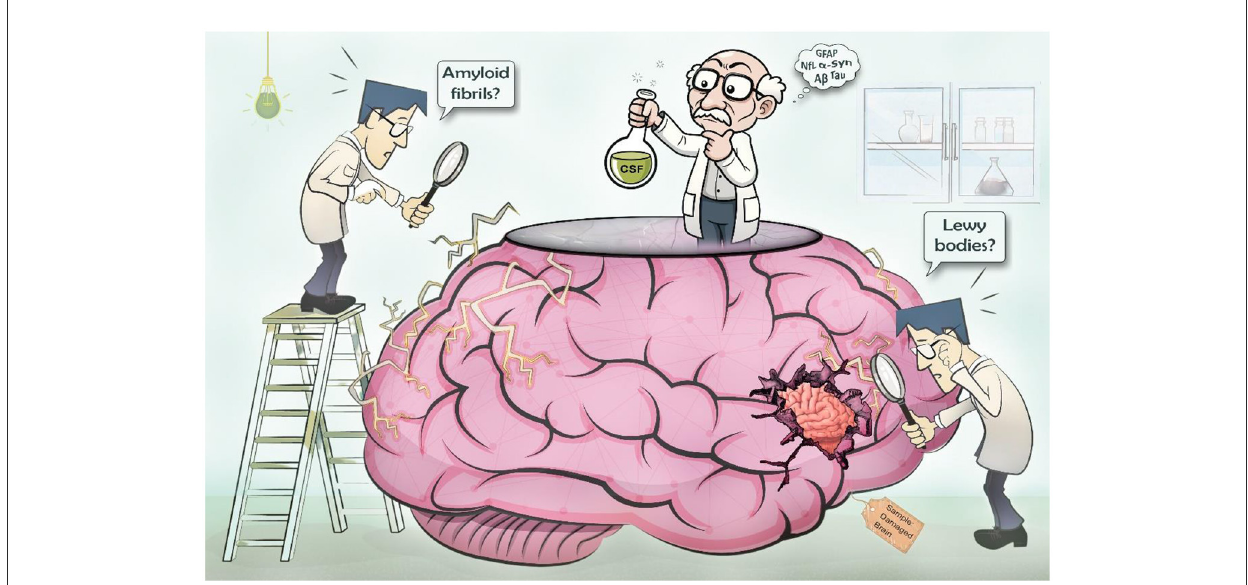
FIGURE1 Challenges in identifying biomarkers for neurodegenerative diseases. Identifying biomarkers for neurodegenerative diseases is challenging because of the inaccessibility of the brain. As a result, there is a lack of detailed understanding of the underlying pathology. Additional challenges are variability in clinical presentation and overlapping symptoms, and the long latent period of many of these diseases making it difficult to pinpoint specific biomarkers for diagnosis and prediction of disease